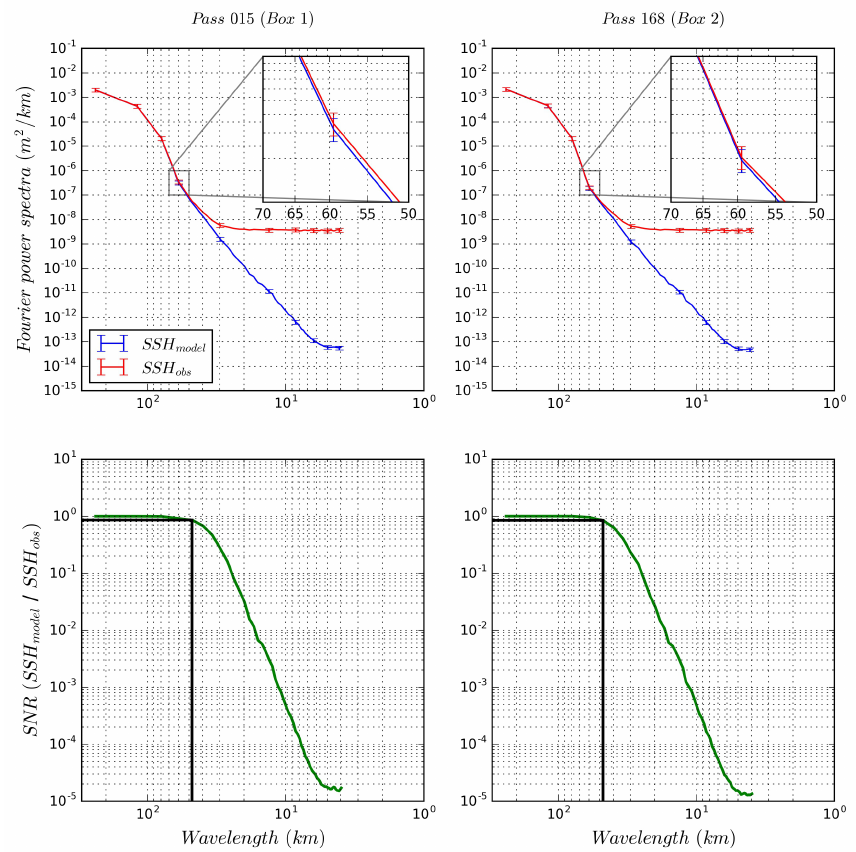
Figure 6. ( Top ) Spectra of the data before filtering, from cycle 1 to 122, corresponding to box 1 (pass 15), ( left ), and to box 2 (pass 168), ( right ). Error bars denote 95% confidence intervals. ( Bottom ) Corresponding Signal to Noise Ratio (SNR), with a horizontal black line indicating where the noise is more than 15% of the signal, and the vertical line the corresponding